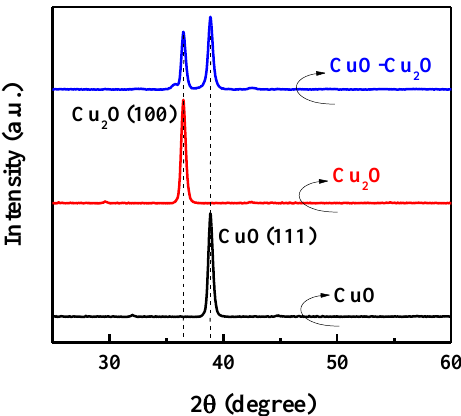
Figure 3. XRD spectra of the CuO–Cu 2 O thin films and control CuO and Cu 2 O thin films with a thickness of 500 nm.